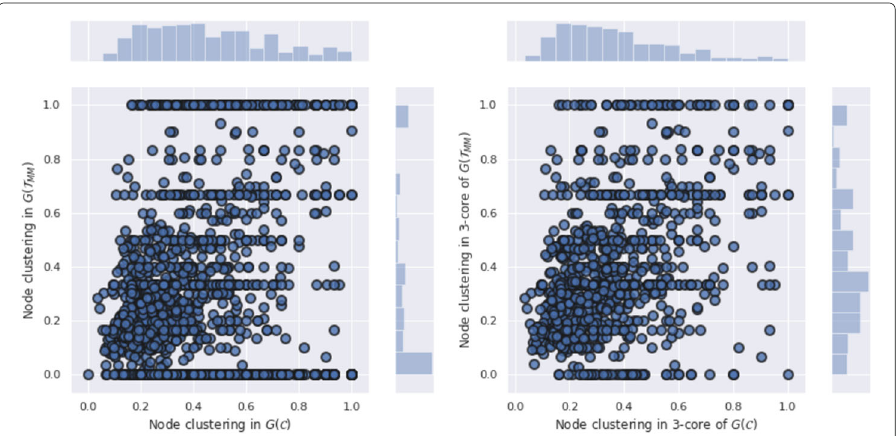
Fig. 10 Node clustering coefficients distributions and correlations in Left - G ( C ) and G ( T MM ) , Right - the 3-cores of G ( C ) and G ( T MM ) to avoid small degree effects on the